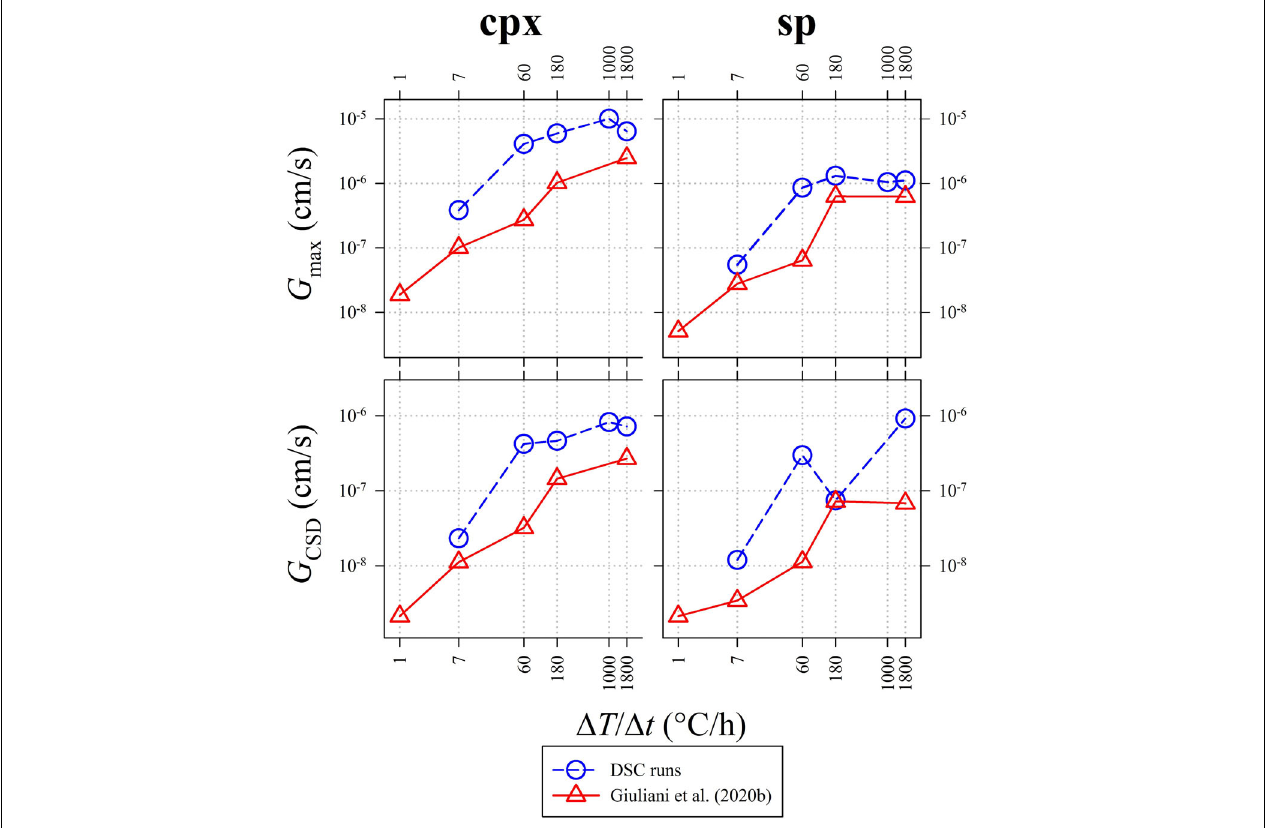
FIGURE 8 | Variation of the maximum growth rate ( G max ; top) and the average CSD growth rate ( G CSD ; bottom). Data from DSC experiments ( Table 5 ) are compared with those reported in Giuliani et al. (2020b).